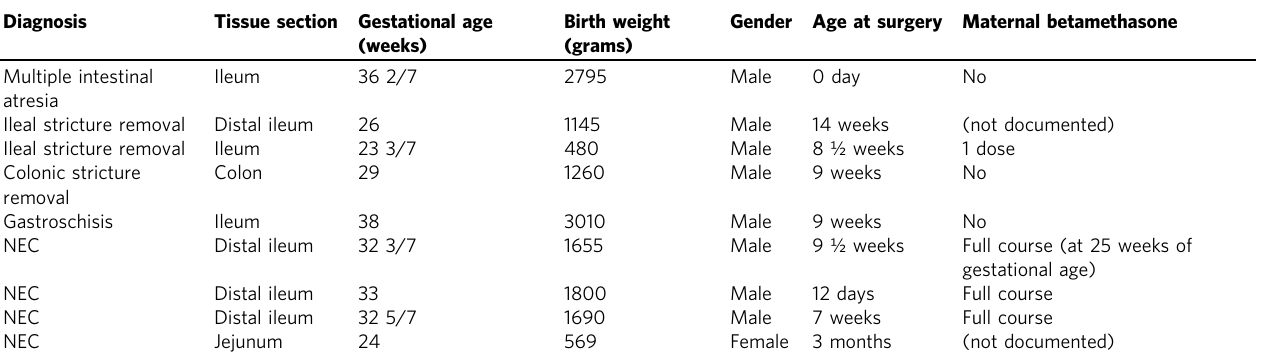
Table 1 Human intestinal tissue patient